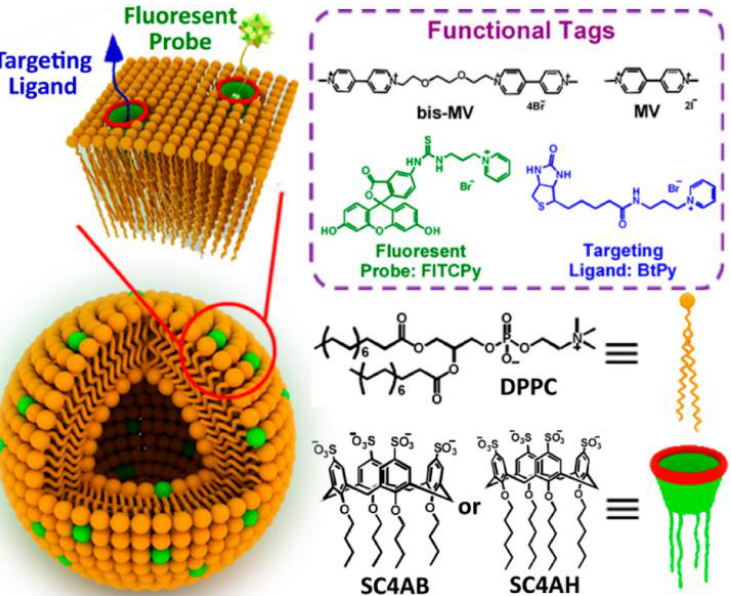
Figure 7. Schematic representation of a multifunctional liposomes, chemical structures of func- tional tags, DPPC, SC4AB and SC4AH. Reprinted with permission from [127]. Copyright 2015 American Chemical Society.